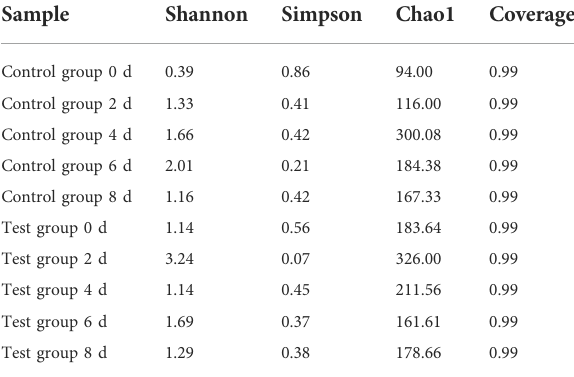
TABLE6Effects offermentationmedium onmicrobial diversityonthe surface of cigar tobacco